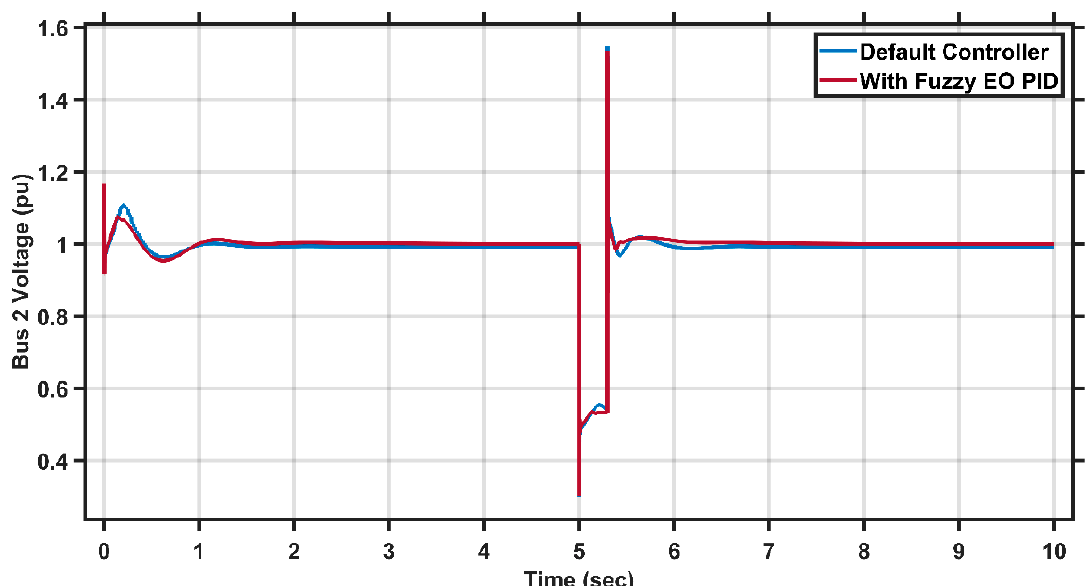
Figure 22. Bus 2 voltage at faulty condition for the IEEE 9-bus system.